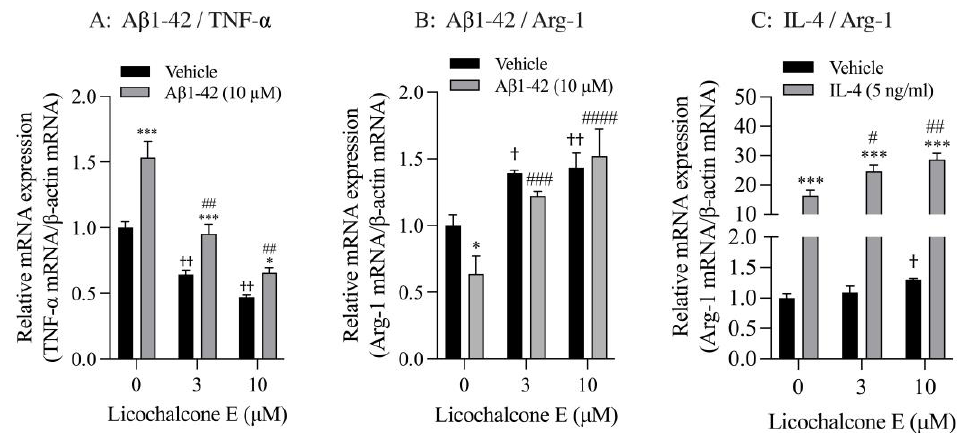
Figure 6. Effect of Lico E on TNF- α and Arg-1 mRNA expression in SIM-A9 cells stimulated with A β 1-42 and IL-4. ( A ) Effect of Lico E on TNF mRNA expression in SIM-A9 cells stimulated with A β 1-42. ( B ) Effect of Lico E on Arg-1 mRNA expression in SIM-A9 cells stimulated with A β 1-42. Cells were treated with various concentrations (0, 3 and 10 µ M) of Lico E for 30 min, followed by stimulation with 10 µ M A β 1-42 for 4 h. Values are the mean ± SD ( n = 3). * p < 0.05 and *** p < 0.0005 compared with vehicle control. Statistical analysis of the data was performed using Š í d á k’s multiple comparisons test. † p < 0.05 and †† p < 0.0001 compared with vehicle control (0 µ M of Lico E). Statistical analysis of the data was performed using Dunnett’s multiple comparisons test. # p < 0.005 and ## p < 0.0005, ### p = 0.0005 and #### p < 0.0001 compared with vehicle control (0 µ M of Lico E). Statistical analysis of the data was performed using Dunnett’s multiple comparison test. ( C ) Effect of Lico E on Arg-1 mRNA expression in SIM-A9 cells stimulated with IL-4. Cells were treated with various concentrations (0, 3 and 10 µ M) of Lico E for 30 min, followed by stimulation with 5 ng/mL IL-4 for 4 h. Values are the mean ± SD ( n = 3). *** p < 0.0005 compared with vehicle control. Statistical analysis of the data was performed using Šídák’s multiple comparisons test. † p < 0.01 compared with vehi cle control (0 μM of Lico E). Statistical analysis of the data was performed using Dunnett’s multiple comparisons test. # p < 0.005 and ## p < 0.0005 compared with vehicle control (0 μM of Lico E). Statistical analysis of the data was performed using Dunne tt’s multiple comparisons test.